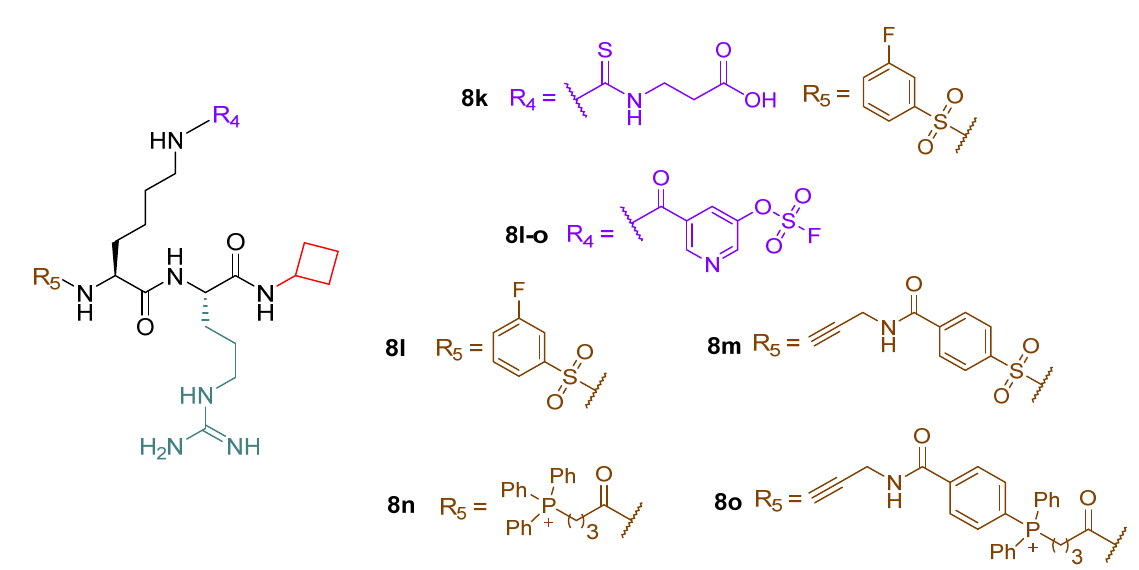
Figure 10. Structures of compounds 8k – o .